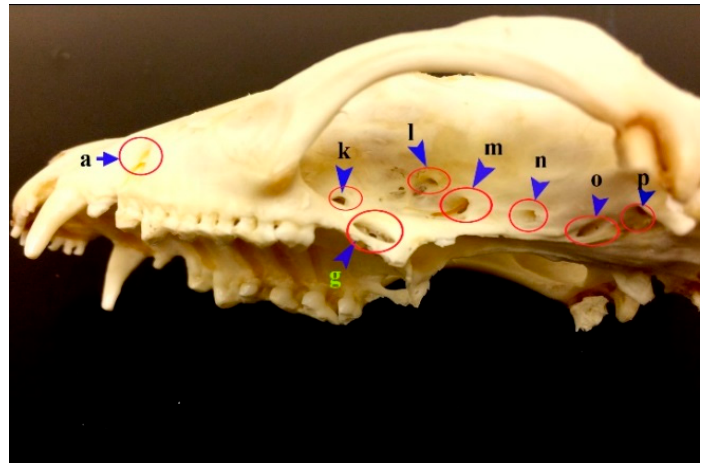
Figure 6. Photograph showing the foramina in the lateral aspect of the skull of the common opossum. a. infraorbital foramen; g. caudal palatine foramen; k. sphenopalatine foramen; l. orbital fissure; m. foramen rotundum; n. rostral alar foramen; o. caudal alar foramen; p. carotic canal; q. transverse canal foramen.